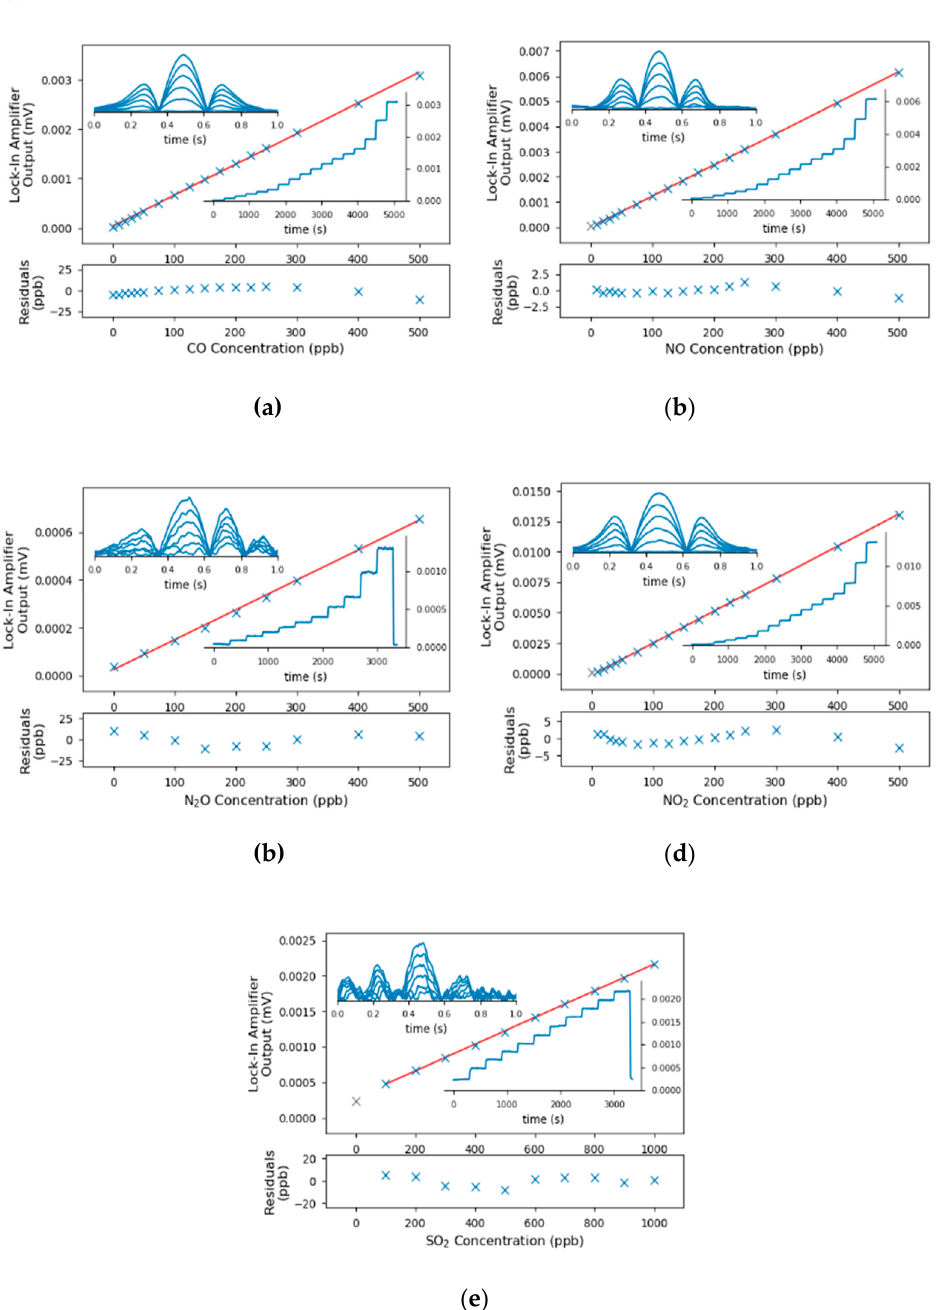
Figure 4. Calibration curves (center), the associated residuals (bottom), the peak signal of the lock-in-amplifier and selected spectra (insets) for the accessible pollutants. The calibration points indicated in grey have been identified as outliers and were excluded from the linear calibrations. The concentrations for the presented spectra in ( a – d ) were 0, 100, 200, 300, 400 and 500 ppbv; the concentrations for SO 2 ( e ) were 0, 200, 400, 600, 800 and 1000 ppbv.